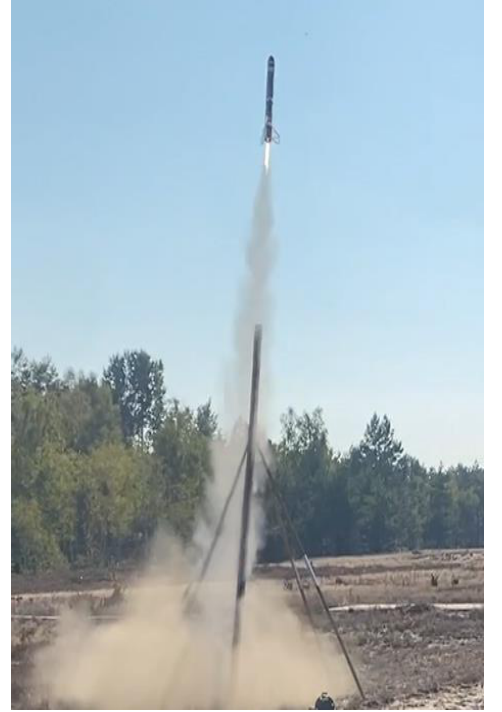
Fig.12. Launch of the experimental rocket power by liquid fueled RDE which utilize CRD at the military test range in WITU,